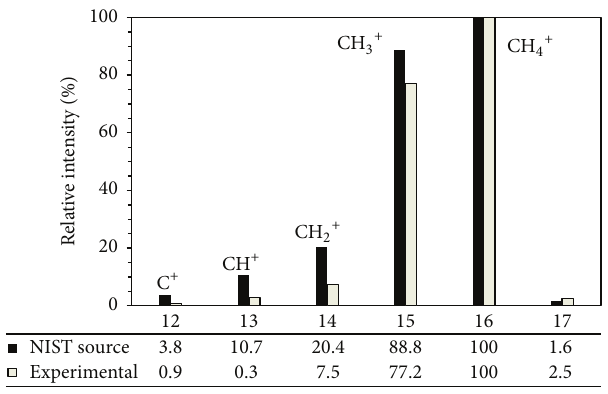
Figure 6: Pure CH 4 mass spectrum obtained experimentally and its relative ion intensities. Reference values from NIST Chemistry WebBook [18] are shown for